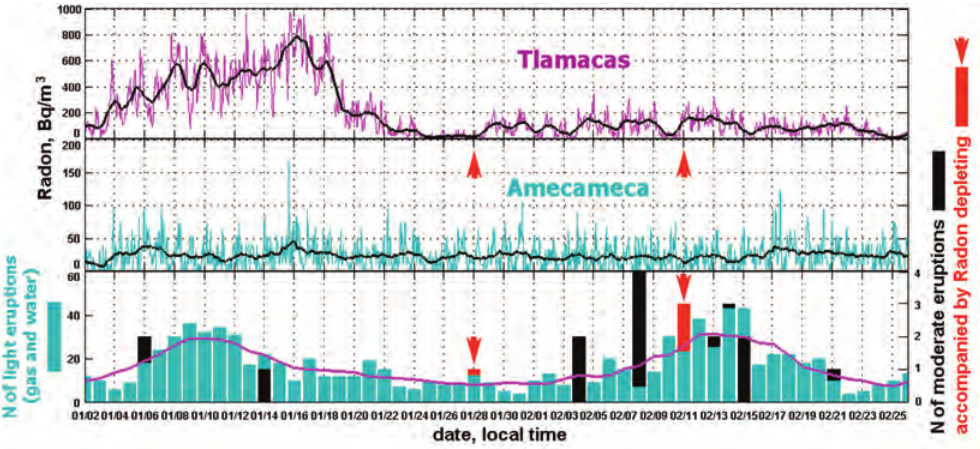
Figure 3. Radon emission monitoring. Top: Tlamacas volcano site. Middle: Amecameca referent site. Monitoring from January to February 2008. Bottom panel: Volcano eruptions. Blue bars, eruptions of gas and water; black bars, moderate eruptions; red bars and arrows, moderate eruptions where radon decreases were